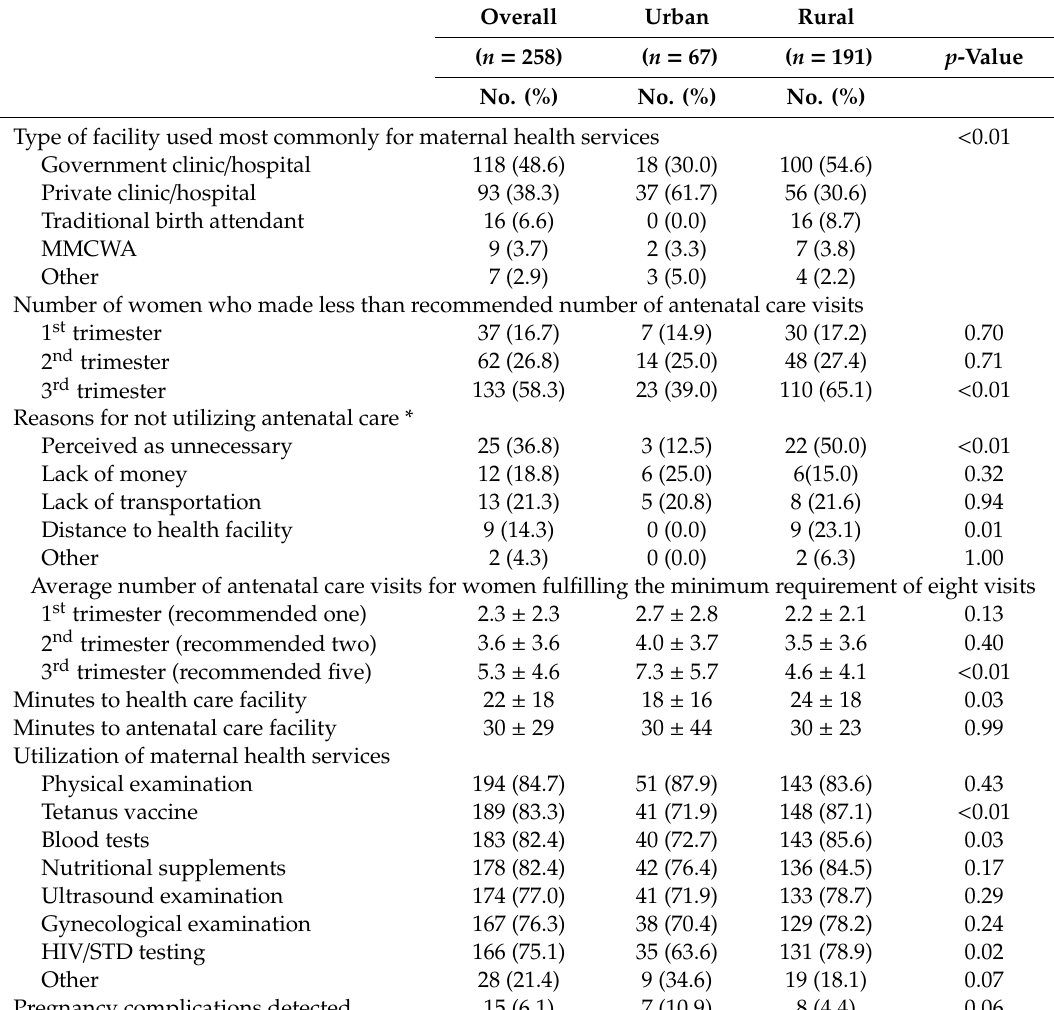
Table 2. Access and utilization of antenatal care